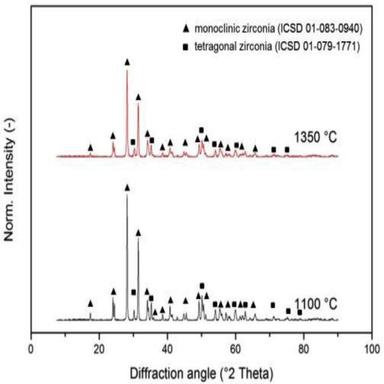
X-ray diffraction pattern of the 10Mg–Zr fibers sintered with a heating rate of 10 K/min a) 1100 °C and b) 1350 °C.